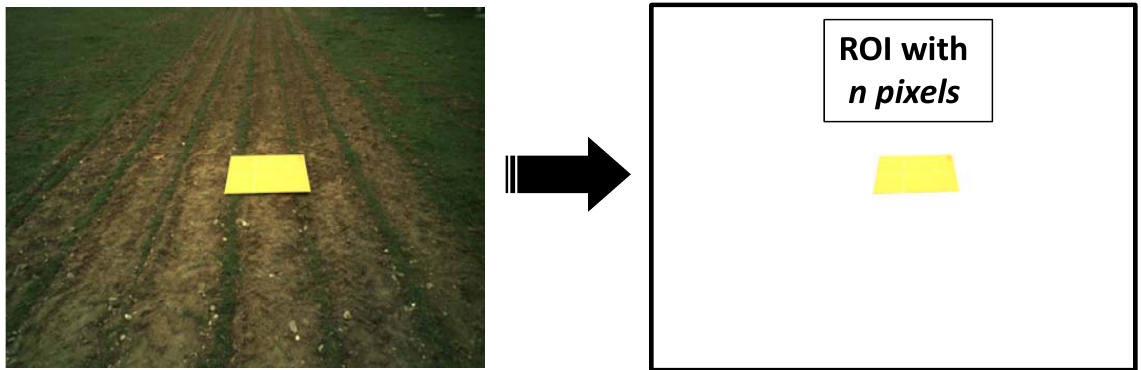
Figure 3. ROI in the field defined by the orange cardboard and number of its